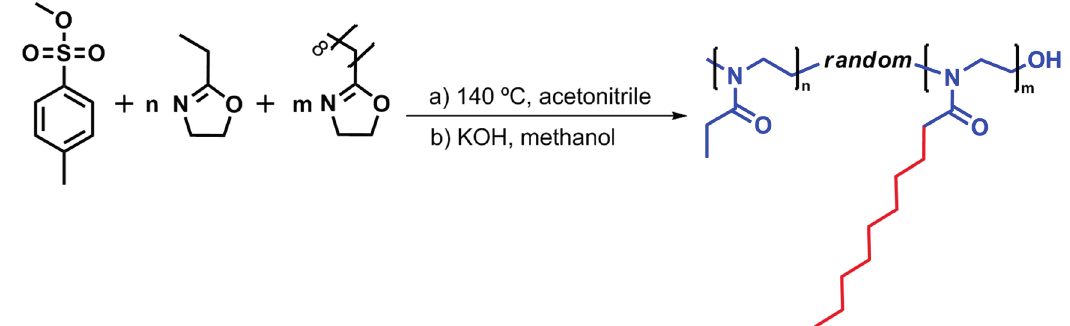
Figure 2. Schematic representation of the living cationic ring-opening copolymerization of 2-ethyl-2-oxazoline (EtOx) and 2-nonyl-2-oxazoline (NonOx) initiated by methyl tosylate resulting in PEtOx- ran -PNonOx random copolymers.